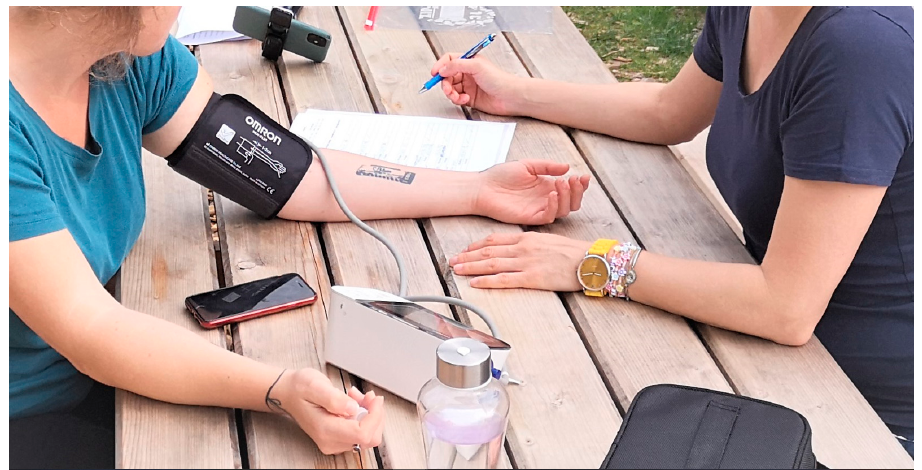
Figure 5. Blood pressure measurement with validated and clinically approved device. Physiological measurements were conducted according to instructions of Diafit, d.o.o., Spodnji Slemen 6, 2352 Selnica ob Dravi, Slovenia. The clinically validated monitor